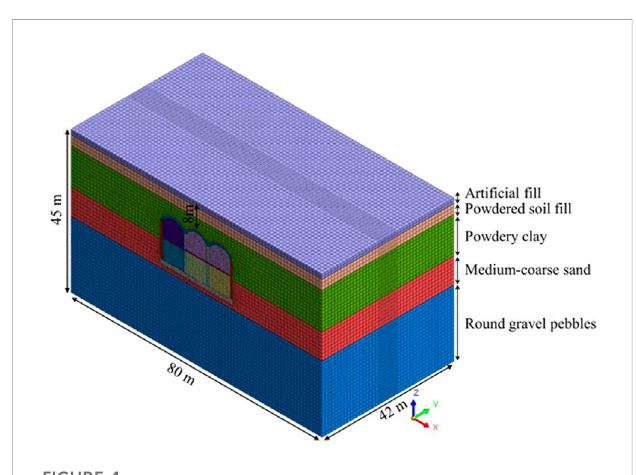
FIGURE 4 Diagram of the numerical calculation